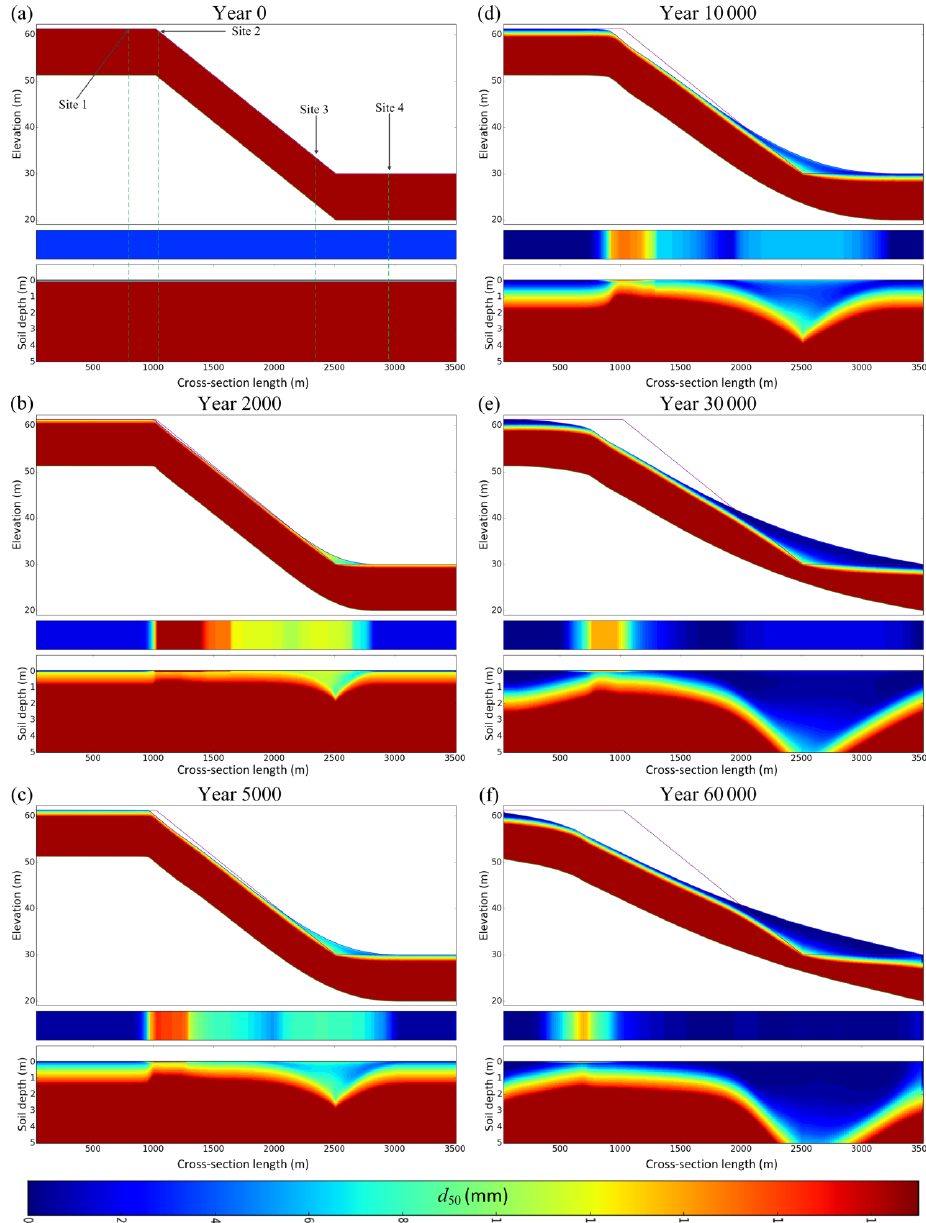
Figure 6. Evolution of the soilscape with the exponential depth-dependent weathering function.